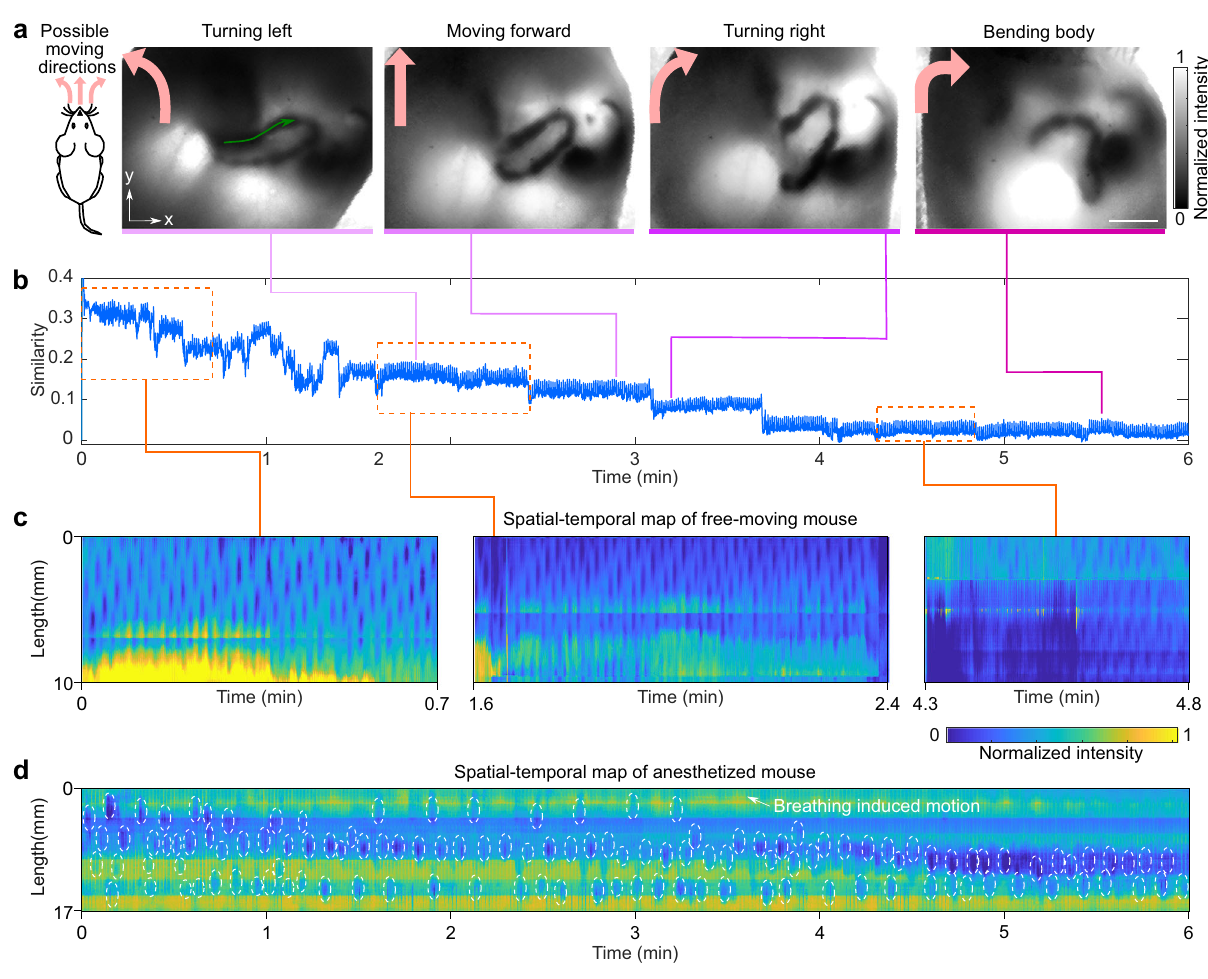
Fig. 4 TIP demonstrated long-duration imaging of mouse intestine. a TIP captured the pro fi le of the mouse intestine when the mouse performed different behaviors in a free-moving state. b The similarity of frames acquired from the free-moving mouse. The similarity changed when the mouse changed its behavior. c Similarity-based data processing generated the long-duration spatial-temporal map for the free-moving mouse. To show the details of the subpattern, only three sections of the whole pattern are shown here. A combined full pattern can be seen in Supplementary Fig. 13a. d The spatial-temporal map of the intestine of an anesthetized mouse, acquired over 6 min. White circles indicate intestinal